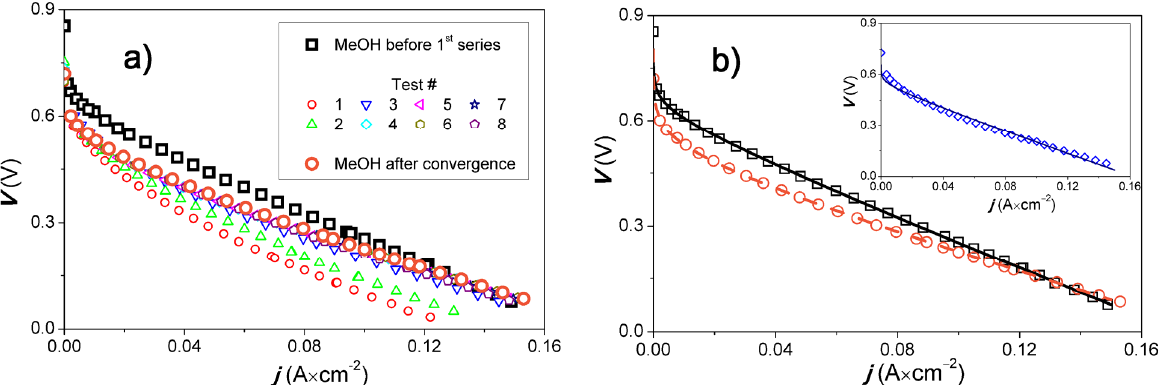
Figure 3. ( a ) Recovery process after first series; ( b ) Control of end of recovery process: Correct